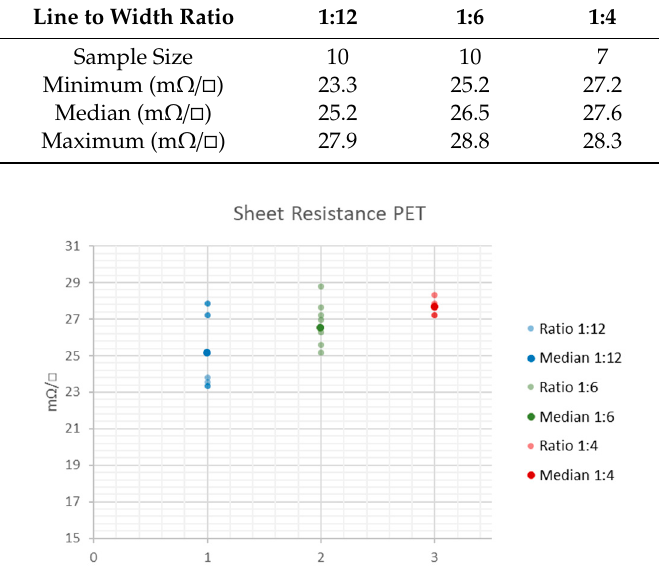
Figure 9. Dispersion of the sheet resistance around the median value on PET substrate.